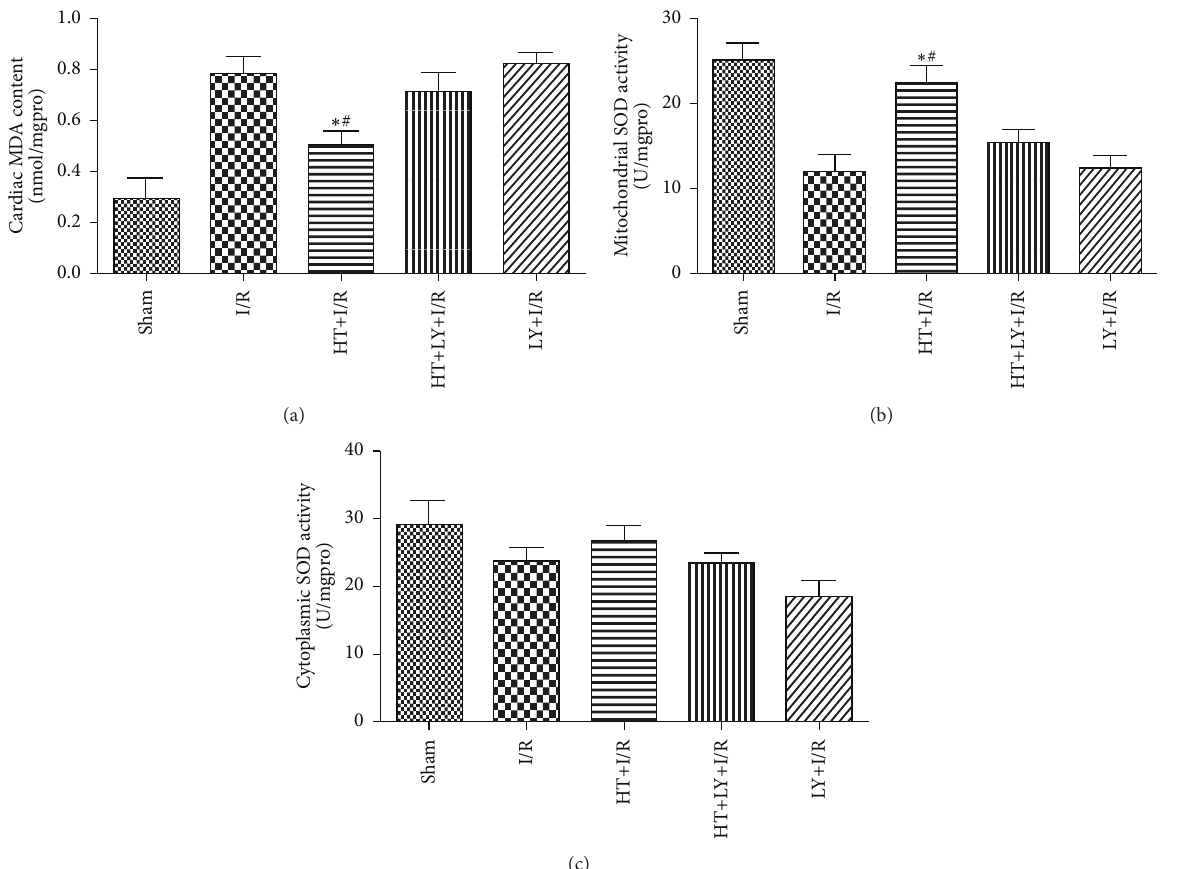
𝑃 < 0.05 ) and an increase in mitochondrial SOD activity ( 23.3 ± 2.2 U/mgpro versus 11.8 ± 2.0 U/mgpro, 𝑃 < 0.05 ) were observed for rats in the HT+I/R group ( 𝑃 < 0.05 ). How- ever, addition of LY294002 attenuated the changes in MDA